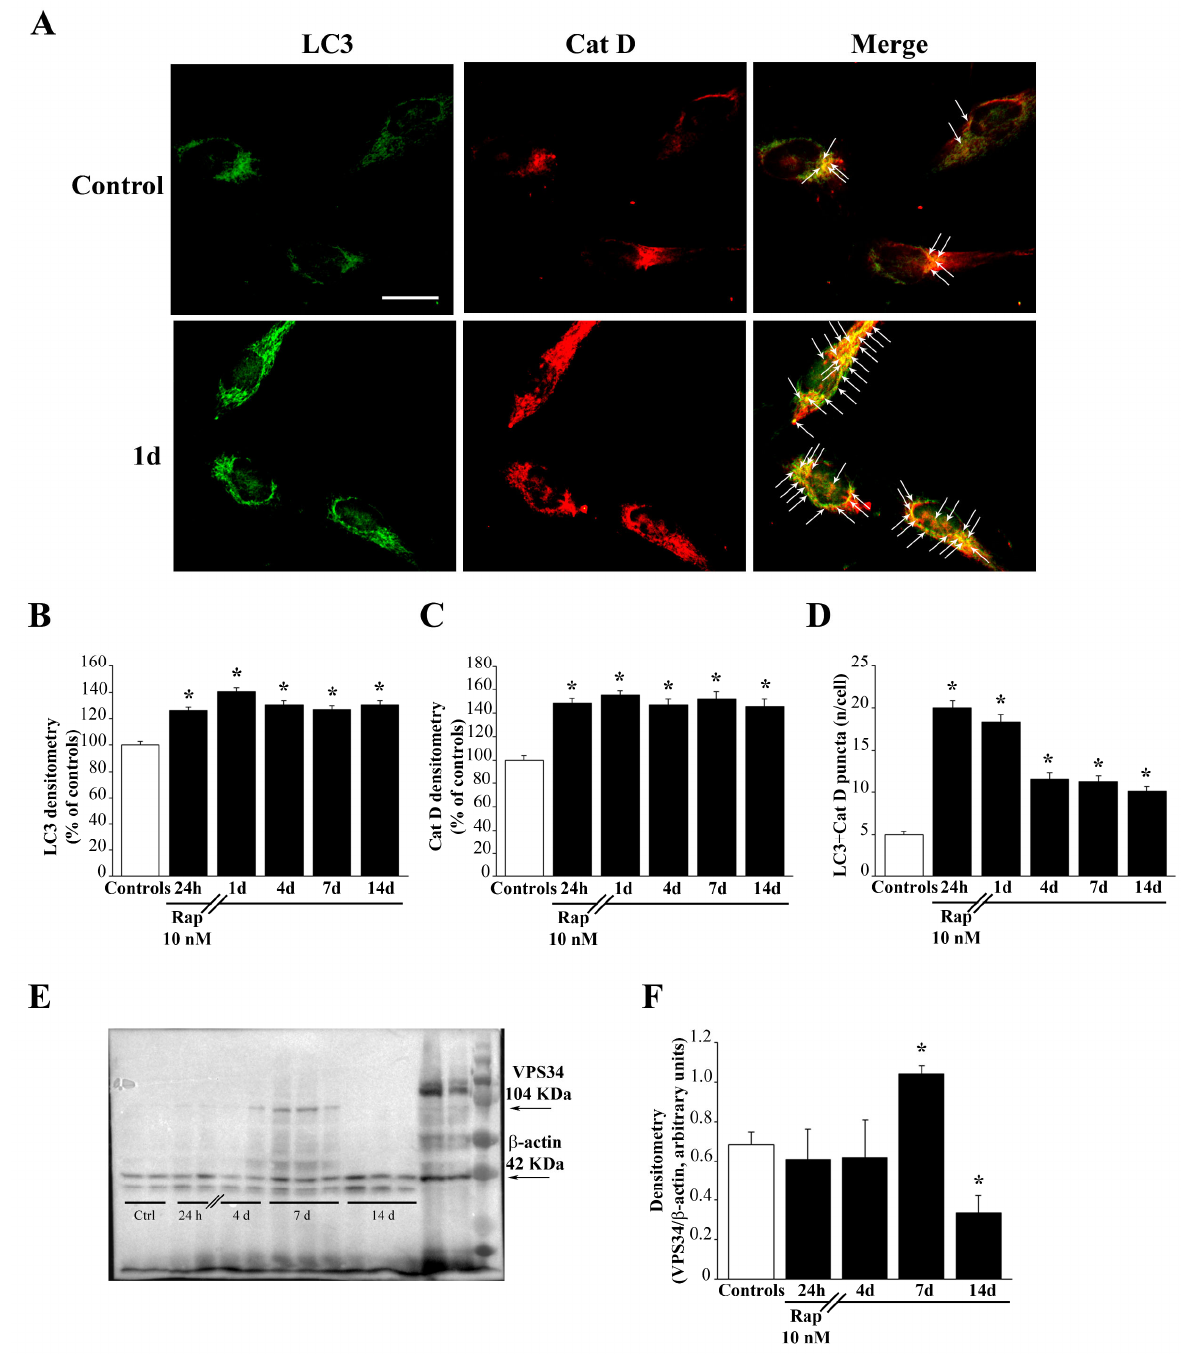
Figure 3. Rapamycin induces autophagy. ( A ) Representative light microscopy of the autophagy markers LC3 and Cat D, showing that rapamycin induces immuno-fluorescent puncta for LC3 + Cat D. Arrows point to merging (yellow) puncta. Graphs report ( B ) LC3 fluorescent density ( C ) Cat D fluorescent density, and ( D ) LC3 + Cat D merging puncta. Counts report means ± SEM from three independent experiments. ( E ) Representative western blotting of the autophagy protein VPS34 at different time intervals following rapamycin. Graph in ( F ) reports that, following rapamycin, an increased expression of VPS34 was measured at 7 days of rapamycin withdrawal. Values are given as the mean ± SEM of optical density measured from an average of at least four samples per group. * p < 0.05 compared with controls. Scale bar = 20 µ